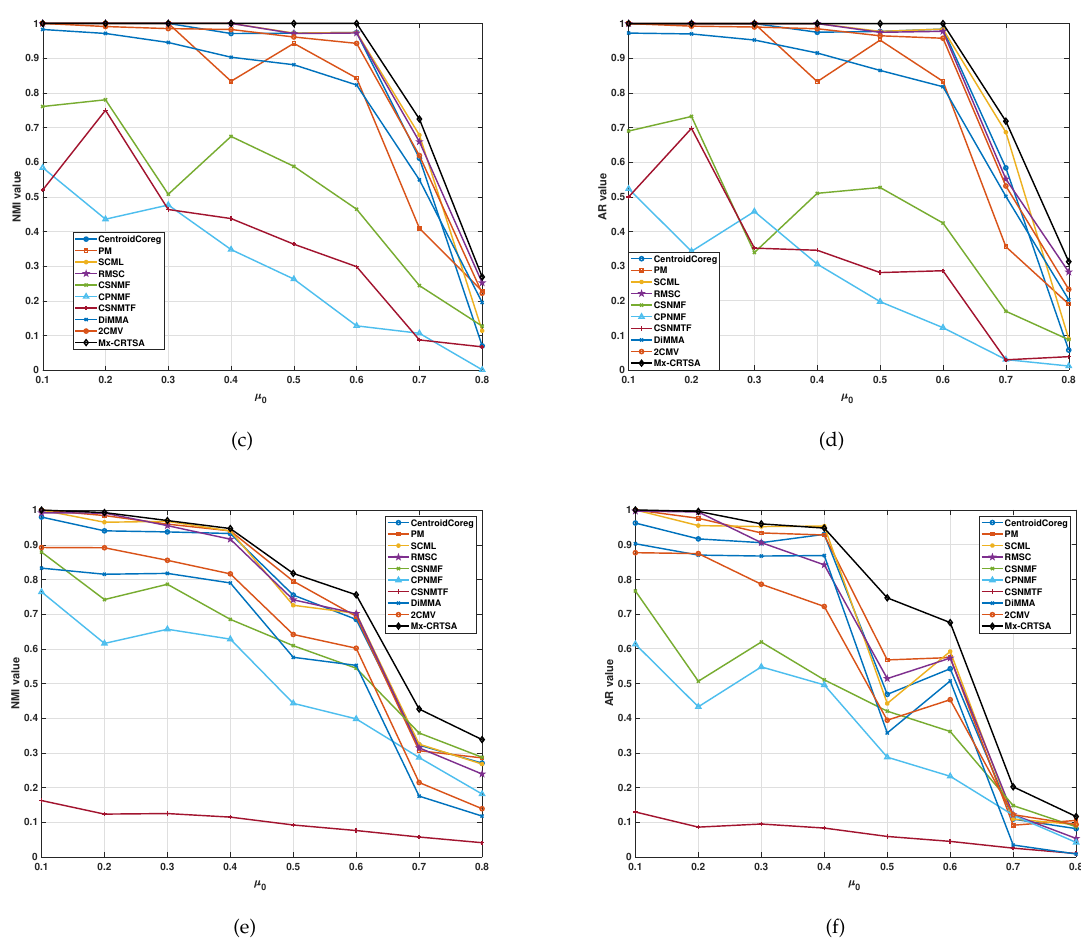
Figure 5. Average NMI and AR scored by the different methods for simulated multiplex networks with n = 128 generated with variable µ 0 . ( a , b ) Multiplex networks with c = 4 and M = 2; ( c , d ) Mul- tiplex networks with c = 4 and M = 3; ( e , f ) Multiplex networks with c = 10 and M =